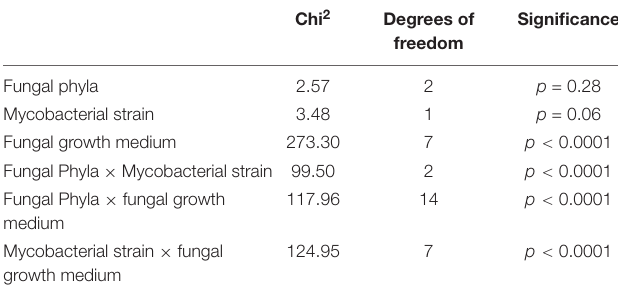
TABLE 3 | Analysis of Deviance Table (Type II Wald Chi 2 tests).